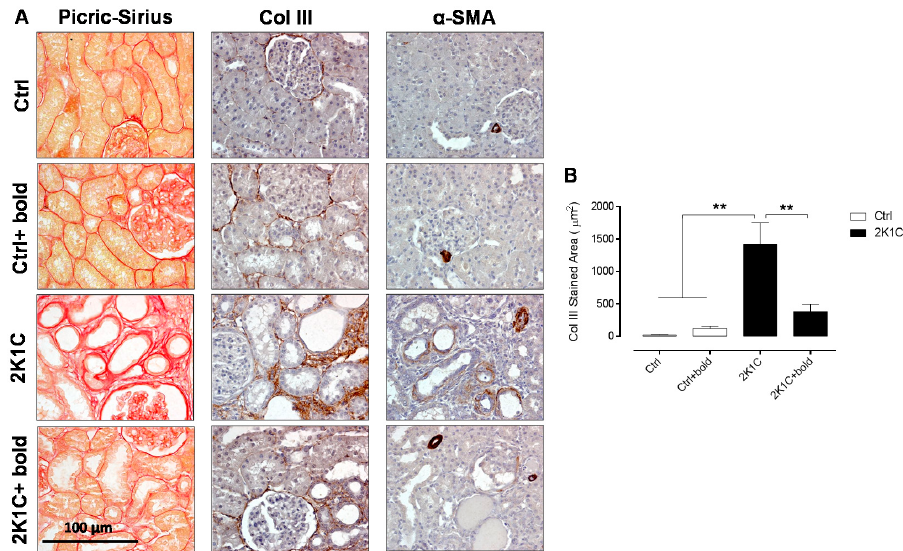
Figure 5. Boldine reduces levels of OPN and ED-1 in 2K1C hypertensives rats. Immunostaining of OPN and ED-1 were performed in renal samples six weeks after 2K1C rats were made hypertensive ( A ); Representative pictures of at least three different kidneys are shown. Scale bar = 100 μ m. Brown staining represents the markers OPN and ED-1. For ED-1, the staining is indicated by black arrows. A Western blot for ED-1 is shown ( B ), with pictures of ED-1 bands and T-ERK used as loading control. Bars represent the mean ± SE. The differences were evaluated by analysis of variance followed by the Tukey post-hoc test. * p < 0.05 and ** p < 0.01 vs. 2K1C ( n = 5/all groups). Int. J. Mol. Sci. 2018 , 19 , x